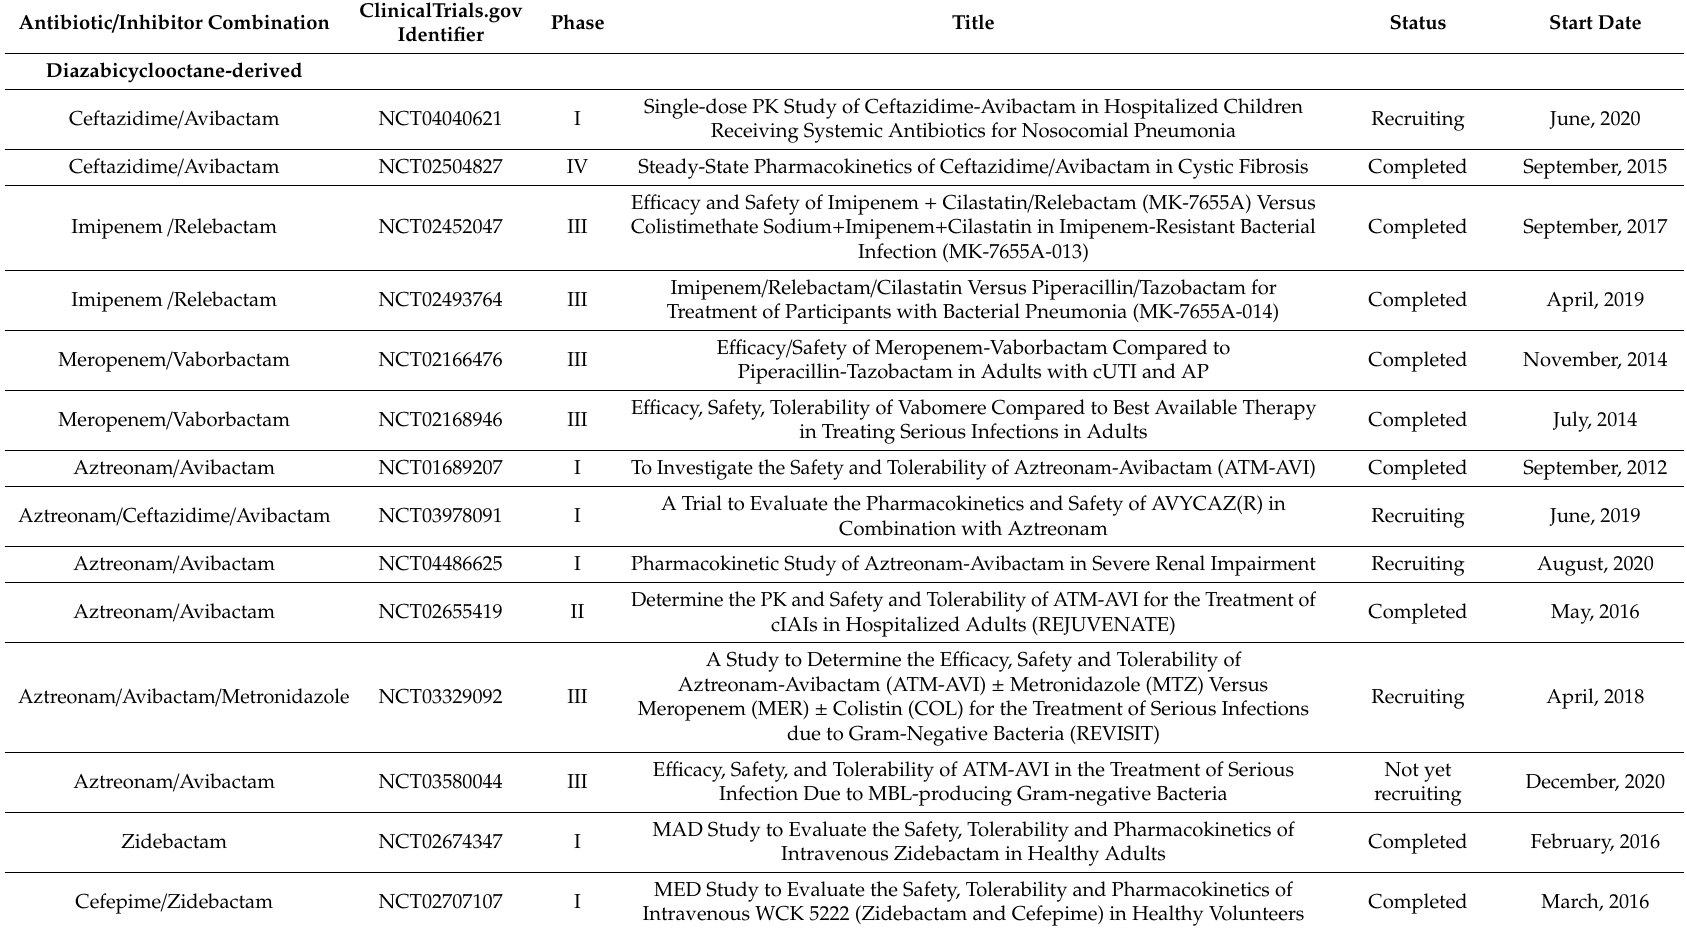
Table 2. Carbapenemase inhibitors undergoing clinical